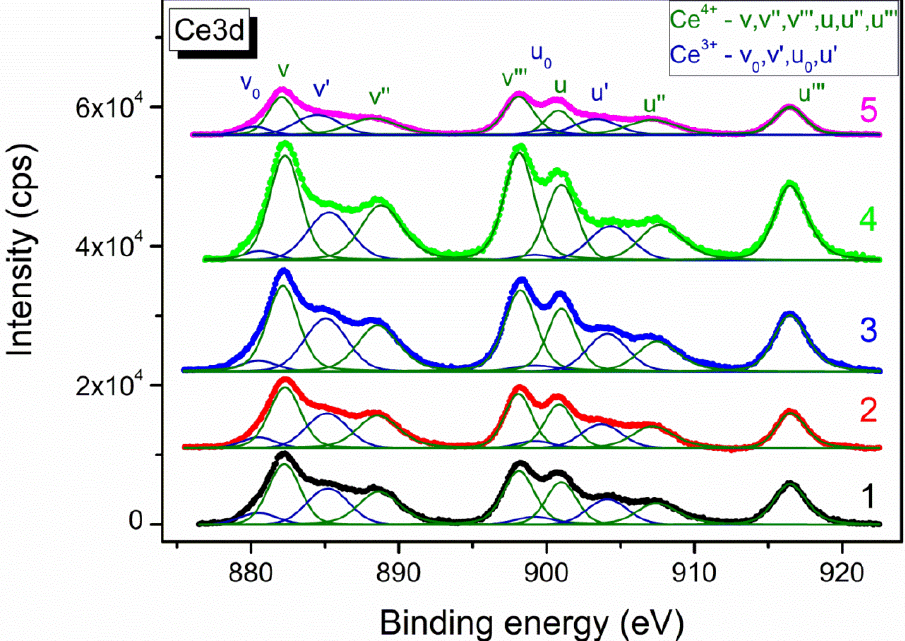
Figure 4. Ce3d XPS spectra of the catalysts reduced at 800 °C. 1—Ni/CeMg-C-S-O; 2—Ni/CeMg-A- S-O; 3—Ni/CeMg-A-S-V-500; 4—Ni-Pd/CeMg-A-S-V, 5—Ni/CeMg-A-P-O.